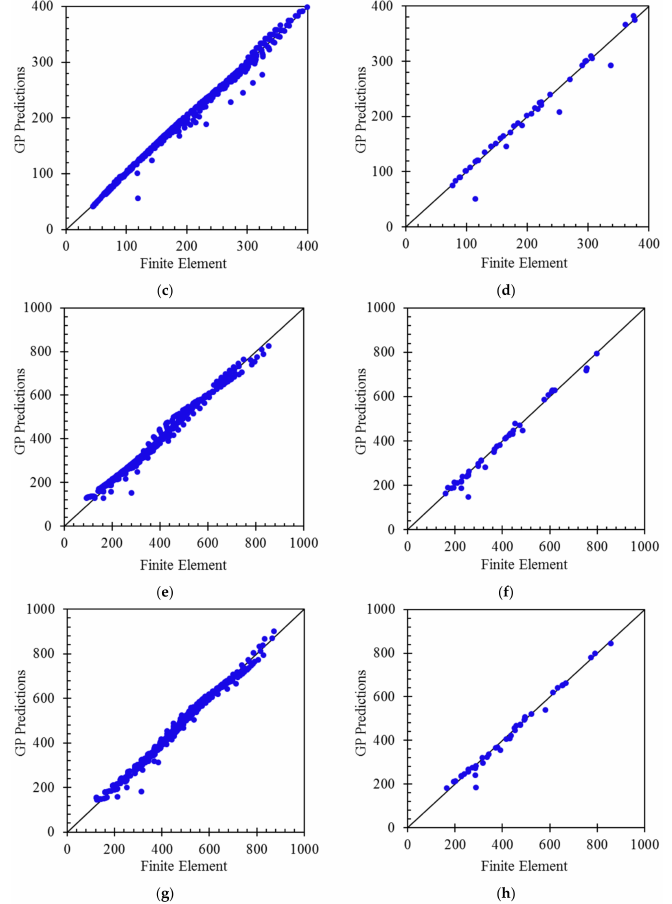
Figure 8. Comparison of the FE outputs with the predictions GP models for the natural frequencies: NF1 train and validation ( a ) and test ( b ) data; NF2 train and validation ( c ) and test ( d ) data; NF3 train and validation ( e ) and test ( f ) data; and NF4 train and validation ( g ) and test ( h ) data.